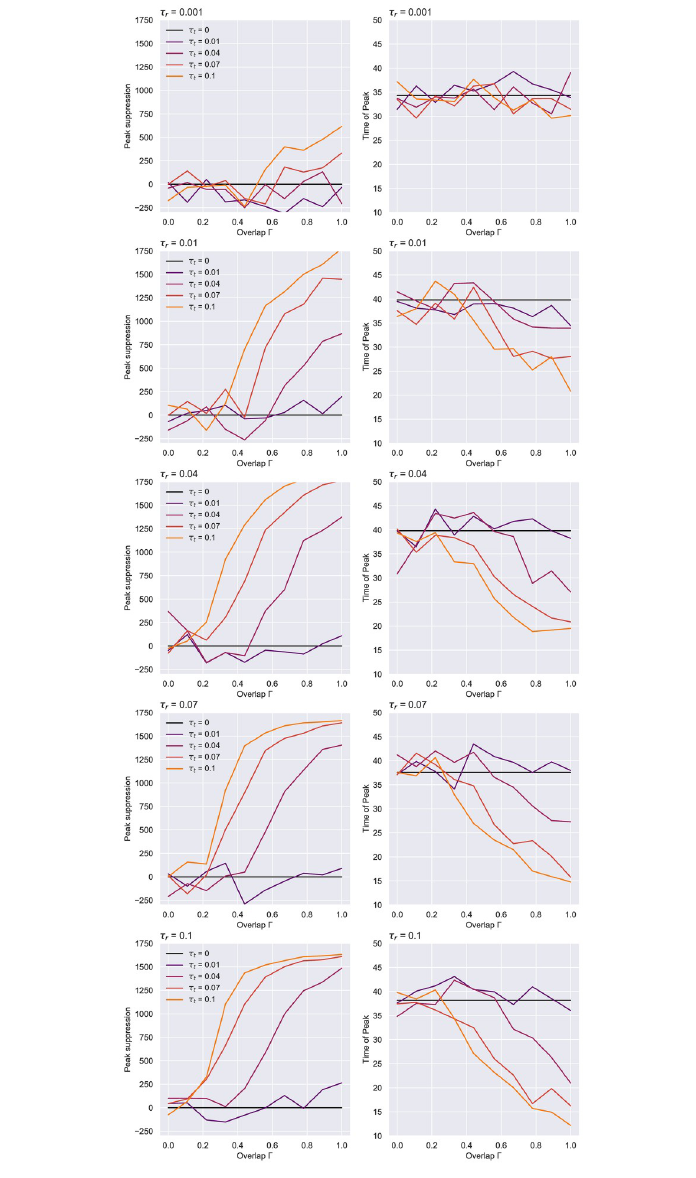
Fig 6. ER network—Peak suppression (left) and the time of peak (right) at various tracing network overlaps. Values are averaged over 105 runs, representing results for N = 10000, K = 10, p a = 0.2. The suppression is calculated by subtracting the average maximal infected point given by each parameter configuration from the average point obtained with no contact tracing ( τ t = 0). Apart from τ r = 0.001 and τ t = 0.01 which produce inconclusive results that we regard as noise, the effectiveness of an epidemic containment strategy expectedly scales with the testing and the tracing rates.